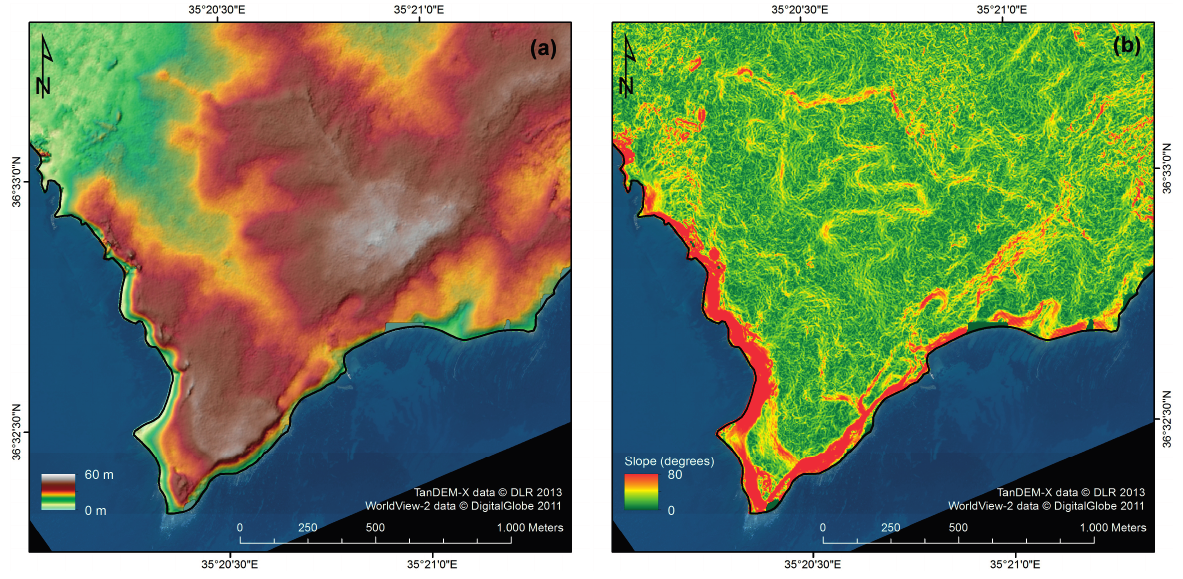
Figure 6. TanDEM-X HS products for the study area around Cape Karata ş . ( a ) DEM and hillshade model (bistatic 2) resampled to 2 m resolution; ( b )